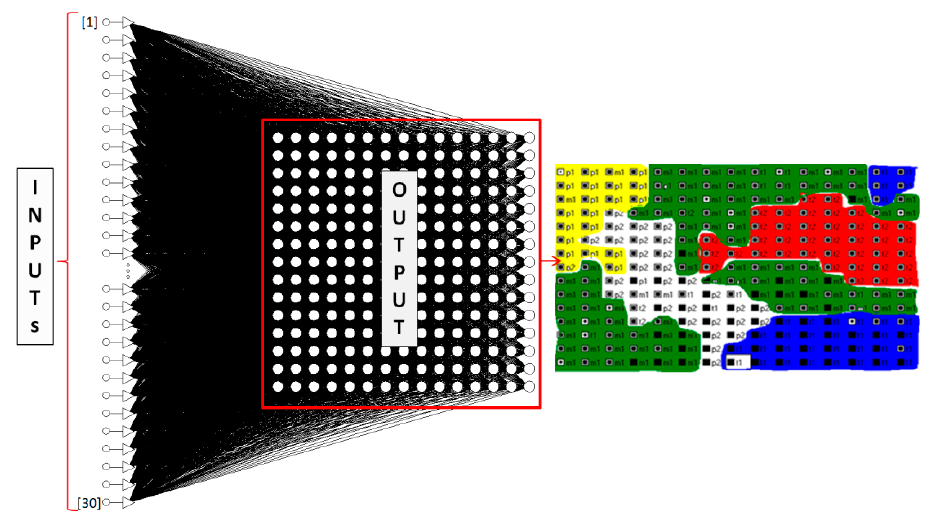
Figure 6. The illustrative nature of the structure of the o ptimal SOFM neural model .